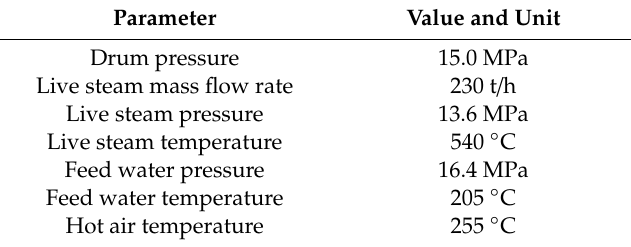
Table 1. The OP230 boiler main operational